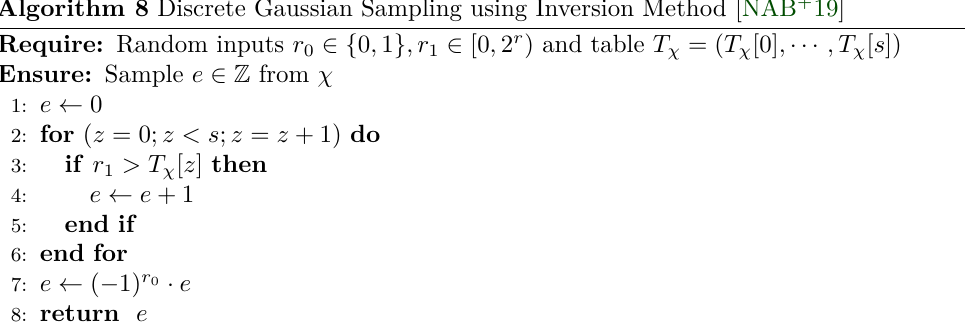
Algorithm 8 Discrete Gaussian Sampling using Inversion Method [NAB + 19]